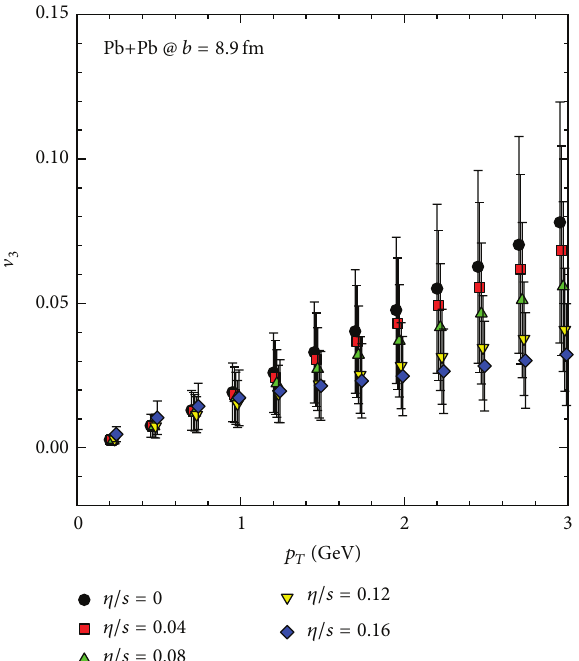
Figure 20: Differential elliptic flow ( V 2 ) for viscosity to entropy ratio 𝜂/𝑠 = 0 , 0.04, 0.08, 0.12, and 0.16. The colored symbols represent the event average, bars, and the variance. The figures are from [138].